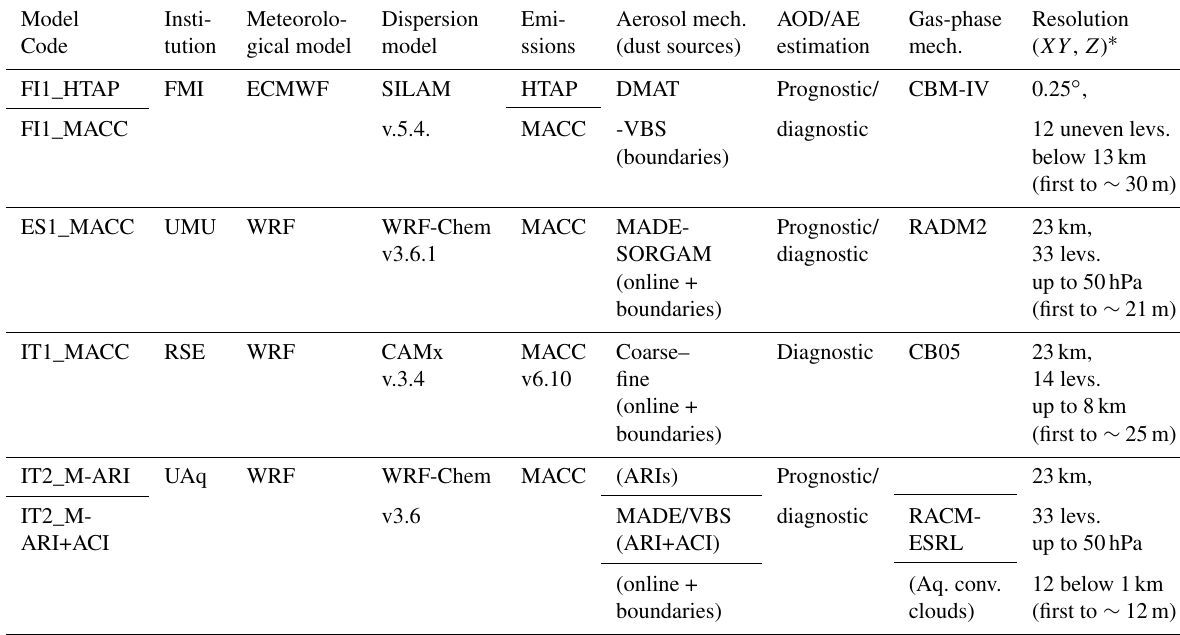
Table 1. Model simulations.